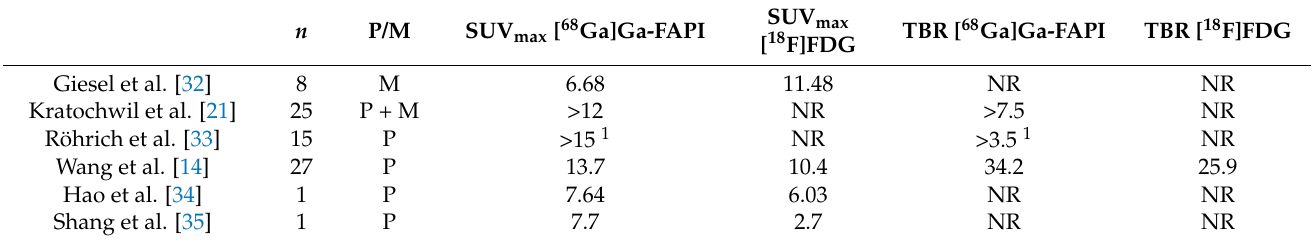
Table 1. Comparison of SUV max and TBR for [ 68 Ga]Ga-FAPI and [ 18 F]FDG in cancer lesions in lung tissue. P = primary lung tumors, M = metastatic lesions located in the